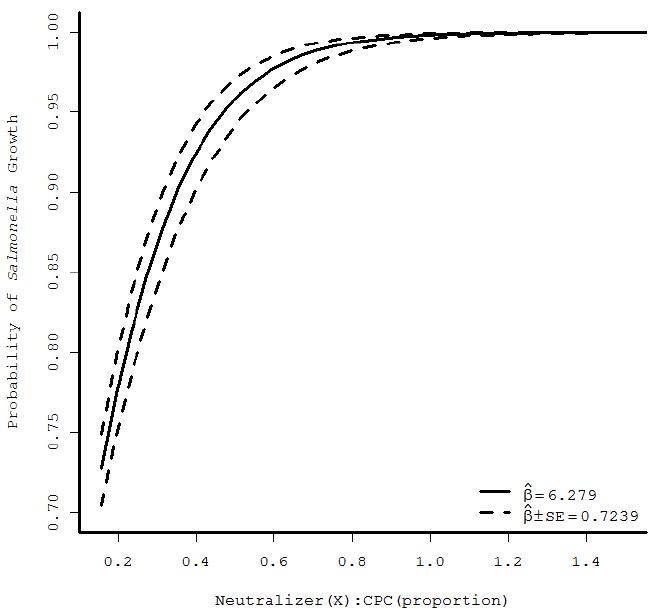
Figure 1. Probability of Salmonella growth following exposure to cetylpyridinium chloride (CPC) and matched neutralizers (lecithin, polysorbate 80), depicting predicted values and confidence band representing one standard error from the linear regression of logit values versus the ratio of neutralizers:sanitizer ( N = 6). SE: standard error of model. Foods 2018 , 7 , x FOR PEER REVIEW